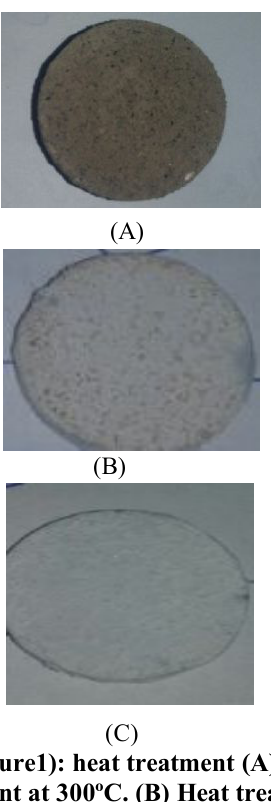
(Figure1): heat treatment (A) heat treatment at 300ºC. (B) Heat treatment at 150ºC. (C) Heat treatment at 100ºC. Test performed on coated Ti